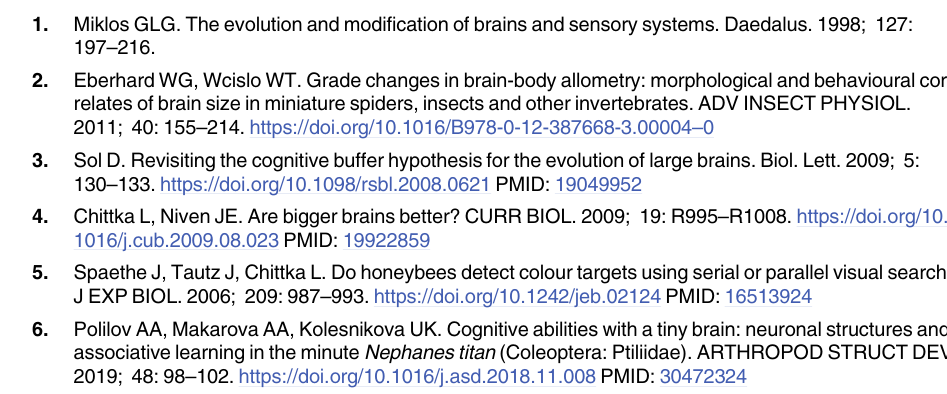
S1 Appendix. Supplementary text, figures, and table. S1 Table. Web variables measured in orb webs built by Leucauge argyra spiderlings and adults in constrained spaces in the labora- tory and the field, classified according to whether the adjustments made in the laboratory and in the field represented continuations of adjustments to smaller spaces made in the field. Data on adults from Barrantes & Eberhard [16]. The criterion used to define a continuation was lack of a significant difference between the slope in “allwebs” (webs built both in the laboratory and the field) by a given spider stage category (spiderling or adult) compared with the slope of only field webs of that category (indicated by “ ✓ ”). Statistically significant differences between all webs and field webs, implying that adjustments in the laboratory were not continuations of adjustments made in the field, are indicted by